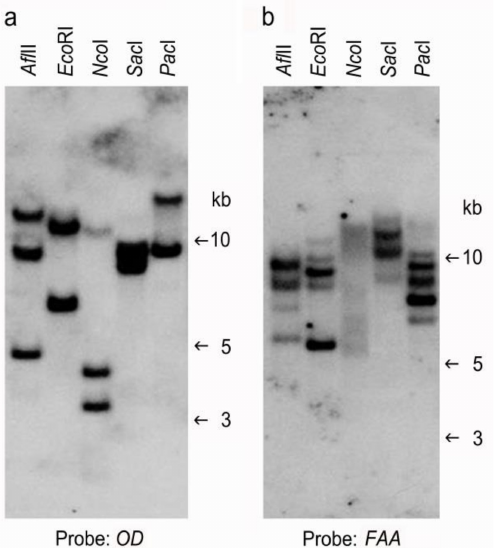
Figure 6. Examination of endogenous FAA and OD genes in wild-type B. pilosa by Southern blot analysis. Genomic DNA was isolated from wild-type B. pilosa , digested with various restriction enzymes as indicated, and probed with full-length FAA cDNA ( a ) or full-length OD cDNA ( b